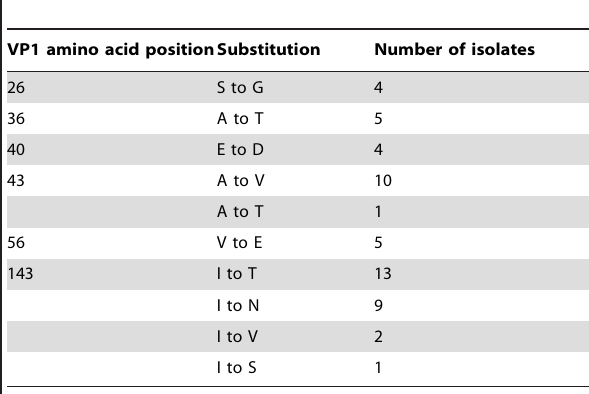
Table 3. Hot sites of amino acid substitutions in the VP1 of 67 PV2 isolates in comparison to Sabin